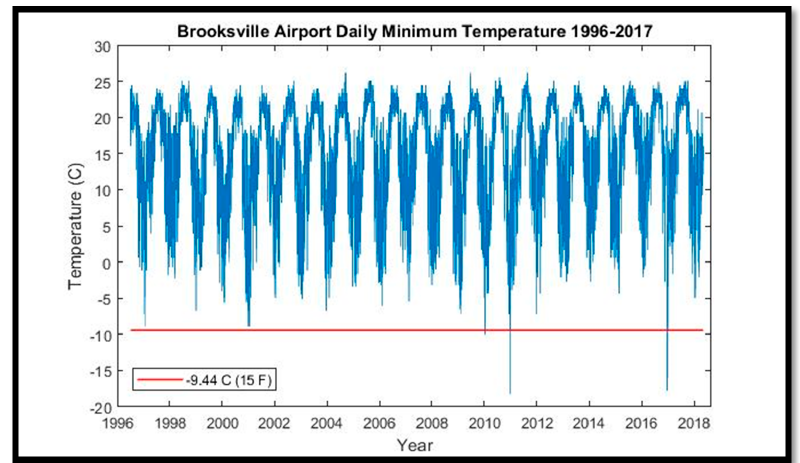
Figure 7. Daily minimum temperature recorded at the Brooksville Airport, Florida, from 1996 to 2017. Sabal palmetto “hardiness” threshold is plotted in red (plants.usda.gov).